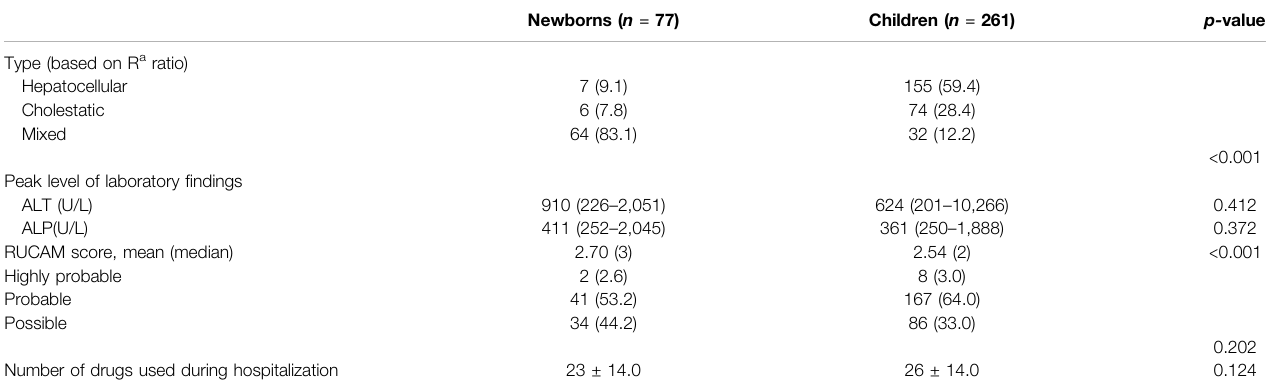
TABLE 2 | The characteristics of DILI.